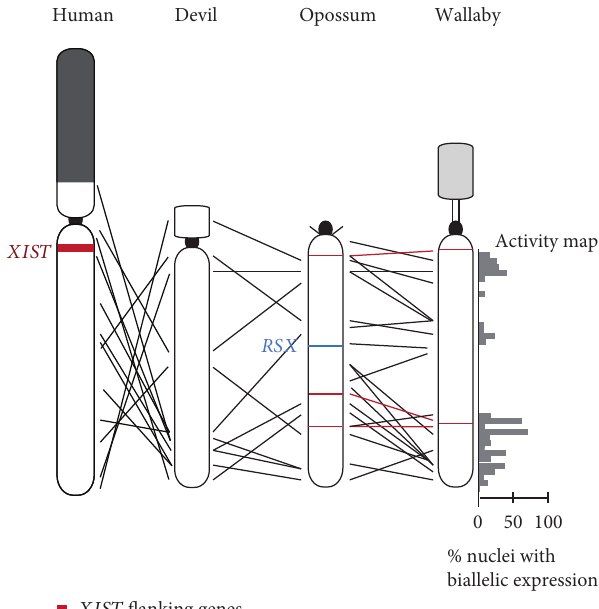
F 3: Comparative map of the human and marsupial X chro- mosomes. e position of XIST, genes �anking XIST in eutherians, and the recently discovered opossum RSX gene are indicated. e dark grey region on the human X corresponds to the region added to the X in the eutherian lineage (XAR). A heterochromatic region of the tammar wallaby X chromosome is indicated in light grey. An activity map is shown to the right of the tammar wallaby X chromosome. Grey bars indicate the percent of nuclei displaying biallelic expression, that is, expressed from both the active and “inactive” X